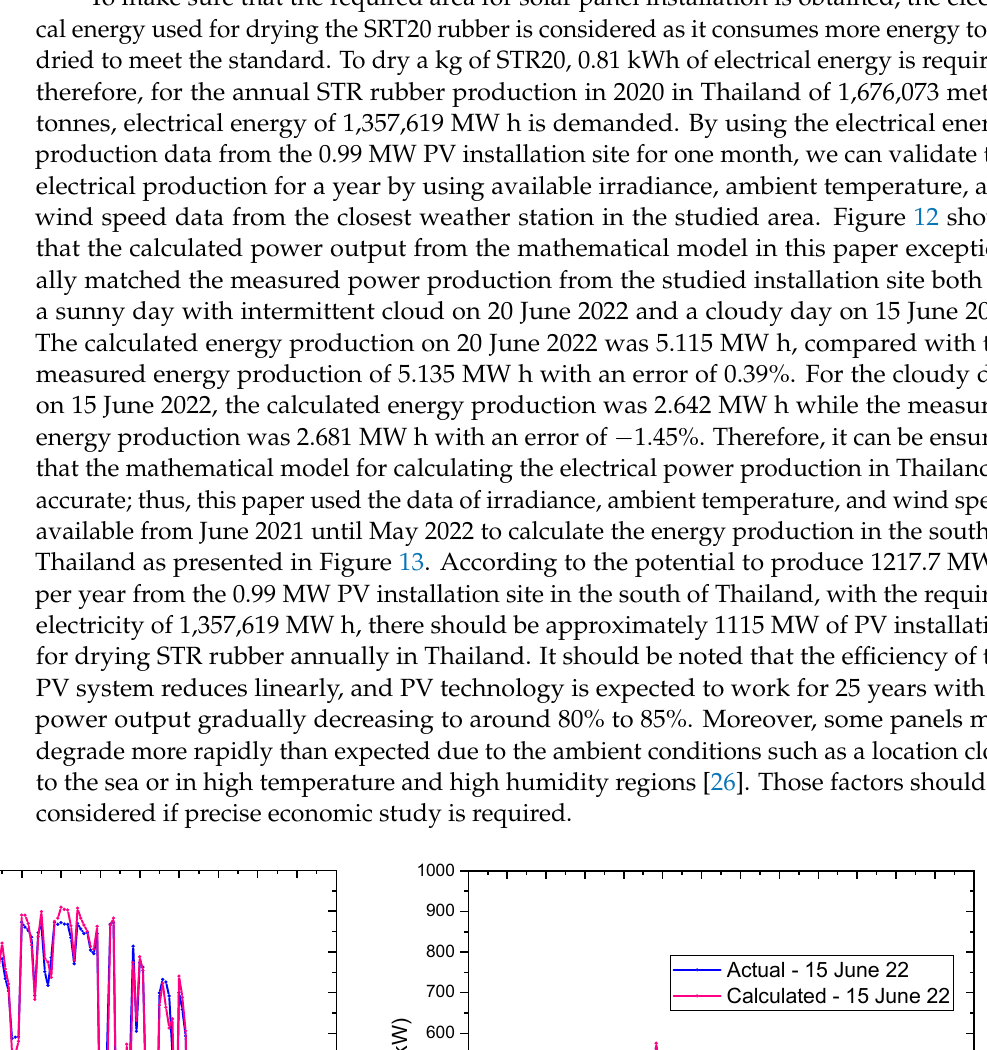
Figure 13. Monthly electrical production in the south of Thailand from a 1 MW PV installation site from June 2021 to May 2022. 5. Conclusions